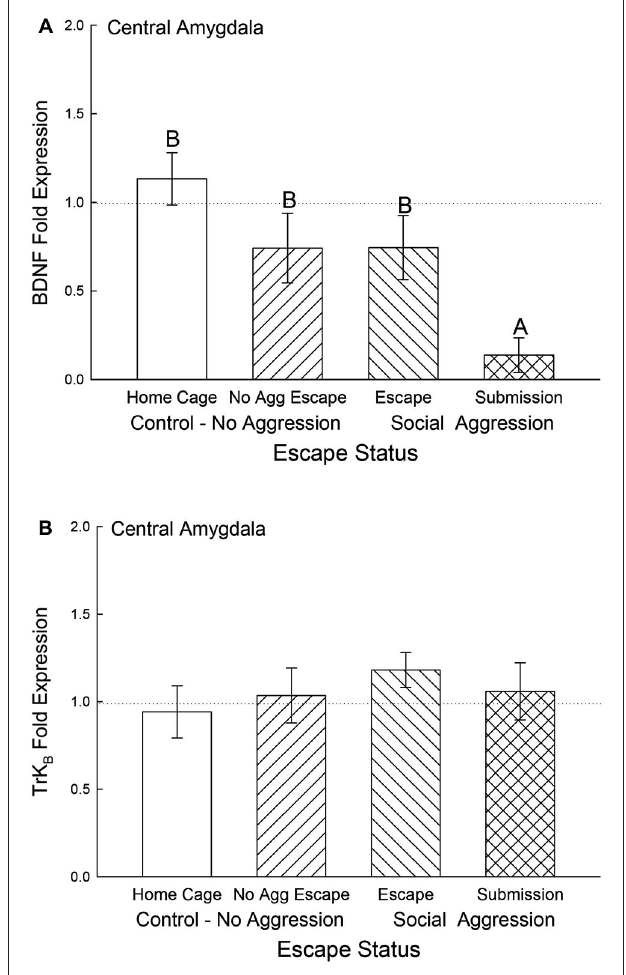
FIGURE 5 | Expectation of social aggression decreases BLA BDNF mRNA and modulates TrK B mRNA . Mean ( ± SEM) fold expression of (A) BDNF and (B) Trk B mRNA from BLA on test day (CS+, US − ) for cage controls (clear bars; BDNF N = 13; Trk B N = 14), after SAM exposure in mice not receiving aggression (bars with left hatch; BDNF N = 7; Trk B N = 6), after SAM plus social interaction in mice escaping aggression during training (right hatch; BDNF N = 7; Trk B N = 7), and submissive mice (cross hatch; BDNF N = 4; Trk B N = 4). Letters above the bar (A, B, C) signify statistical significance ( p < 0.05), such that bars that do not share a common letter (e.g., BDNF Home Cage = C vs. Submission = A) are significantly different, and those that do share a letter (e.g., Trk B Escape = B vs. Submission = AB) are not.